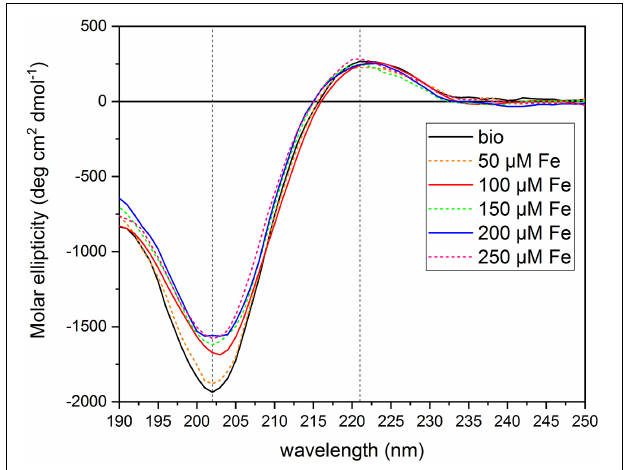
FIGURE 5 | Circular dichroism spectra of protein hydrolysate dissolved in aqueous solutions with FeCl 3 at different concentrations. The figure shows the CD spectra of the PH diluted in aqueous solutions ([N] = 71.5 mg L − 1 ) with different FeCl 3 concentrations [( µ M) 0, 50, 100, 150, 200, 250]. Dashed lines mark 202 and 221 nm wavelengths. Molar ellipticity was calculated referring to a Mean Residual Weight (MRW) fixed at 106.5 g moL − 1 .